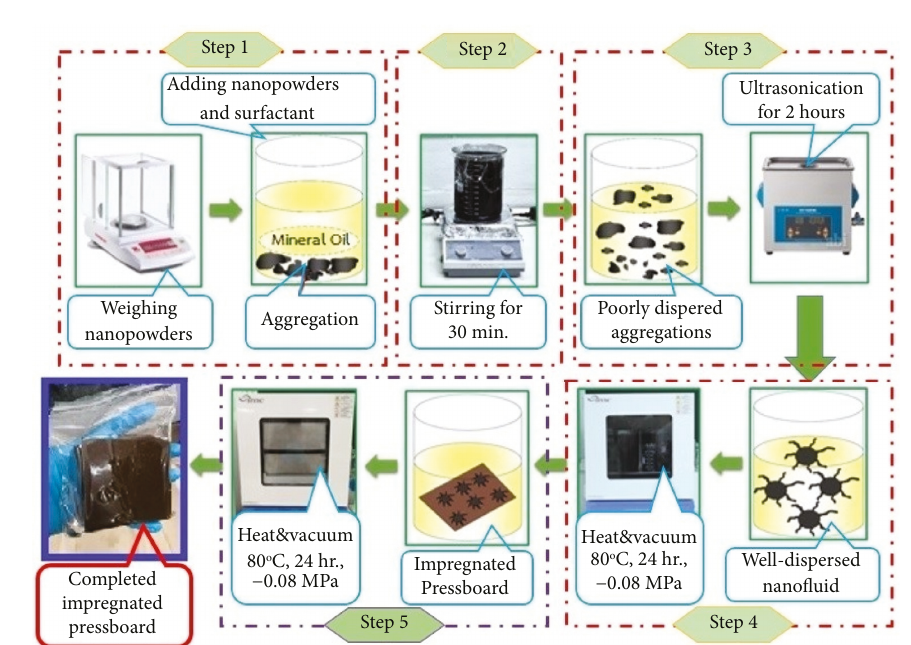
Figure 3: Preparation of nanoparticle-based mineral oil and impregnation of pressboard